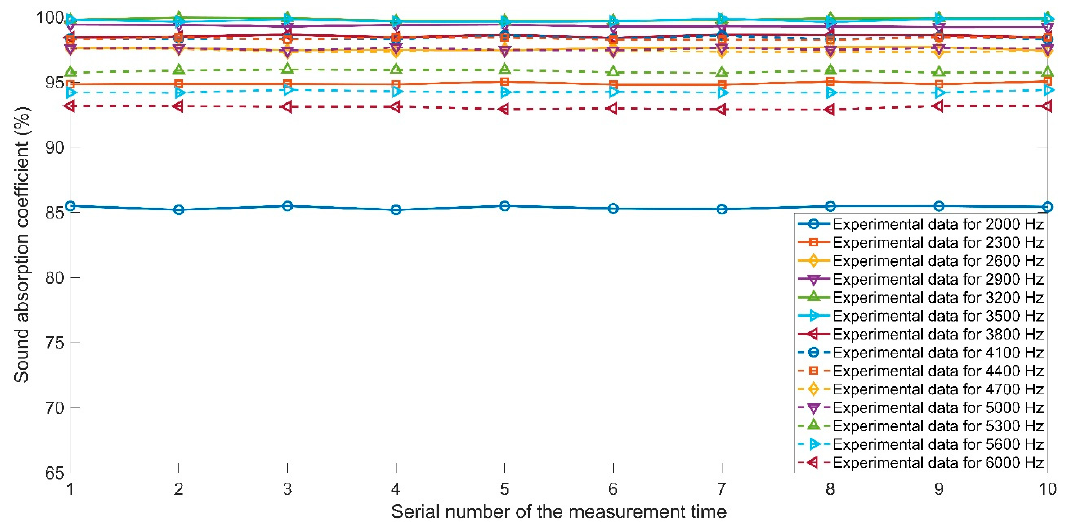
Figure 10. Evolutions of the experimental data of sound absorption coefficients of the PCMC in the 10 standing wave tube measurements.